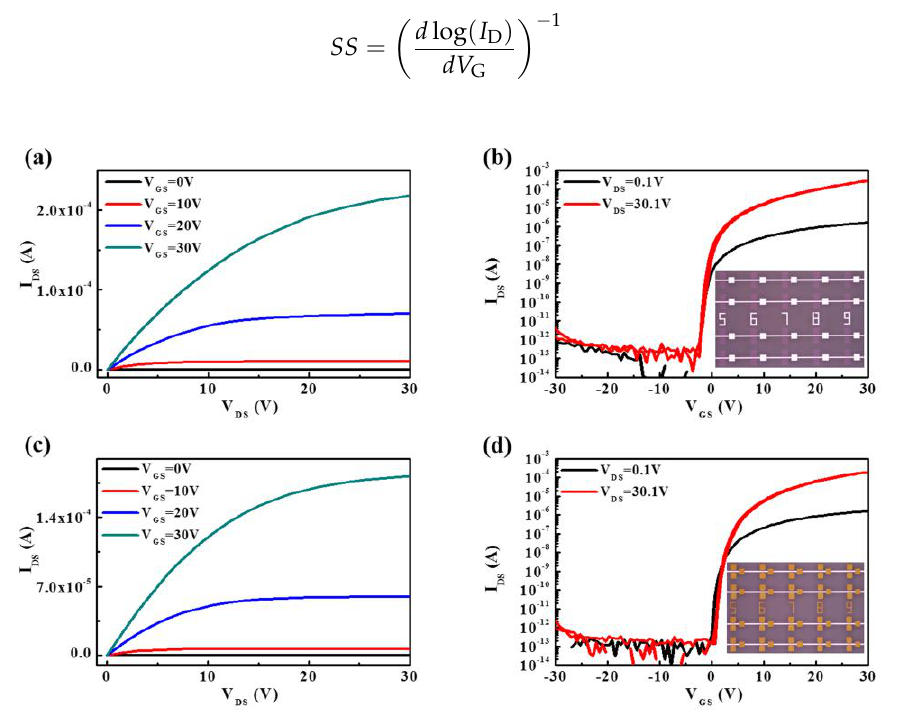
Figure 1. The representative output characteristic curves of amorphous silicon–tin oxide thin-film transistors (a-STO TFTs) with different source/drain (S/D) electrodes: ( a ) ITO and ( c ) Mo. The corresponding transfer characteristic curves with ( b ) ITO and ( d ) Mo.